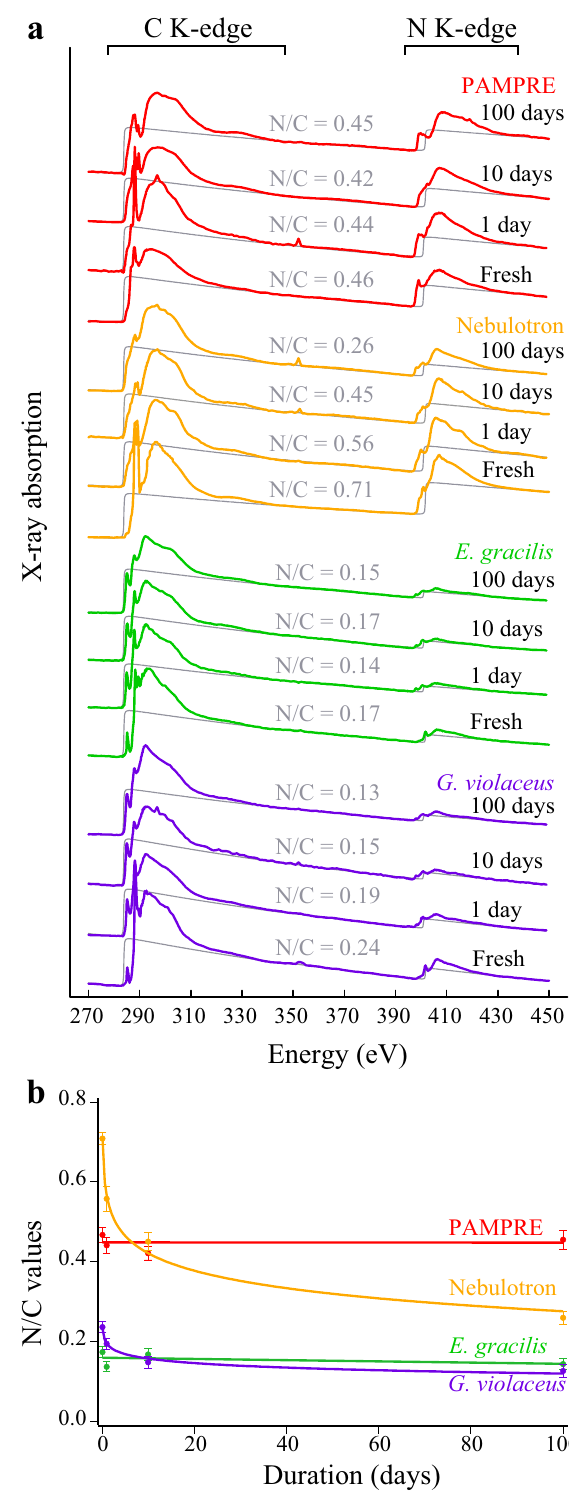
Figure 2. Evolution of N/C values. ( a ) X-ray absorption spectra of organic materials and the corresponding residues of 1, 10 and 100 day long advanced diagenesis experiments performed at 250 °C and 250 bars. ( b ) Evolution of the N/C values with experimental duration. Note that, depending on the organic precursor, the N/C ratio either decreases logarithmically (Nebulotron and G . violaceus ) of remains nearly constant (PAMPRE and E . gracilis ) with experimental